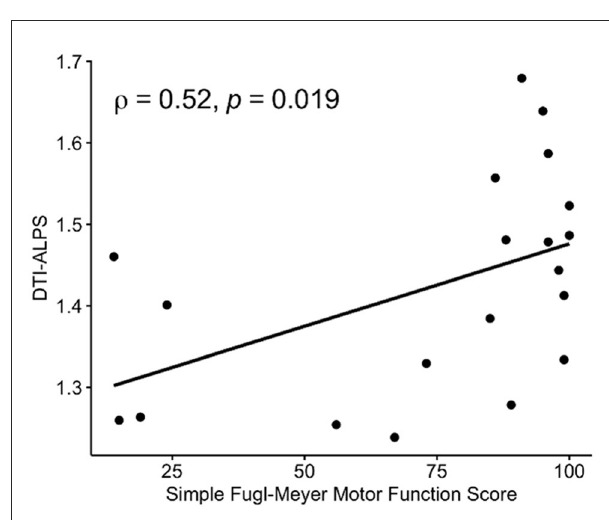
FIGURE5 Associations between DTI-ALPS and Fugl-Meyer assessments (FMAs). A significant positive correlation was observed between the DTI-ALPS index and the simple Fugl-Meyer motor function score in patients with IS. DTI-ALPS, diffusion tensor image analysis along the perivascular space.